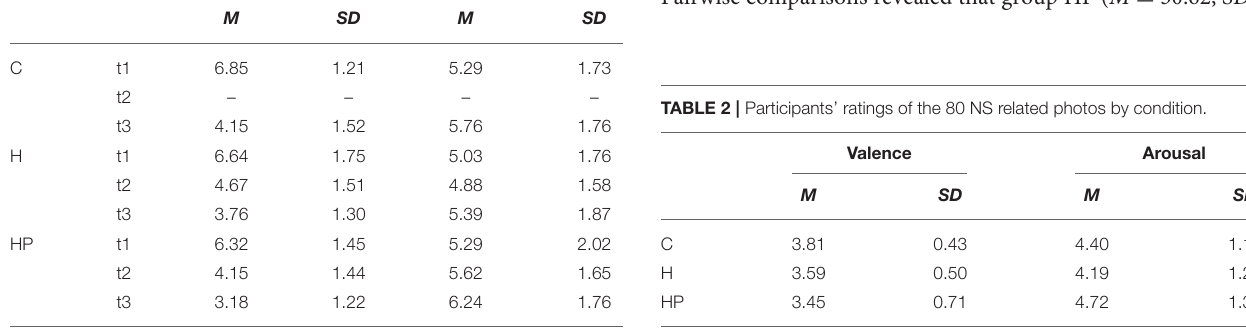
Frontiers in Psychology |